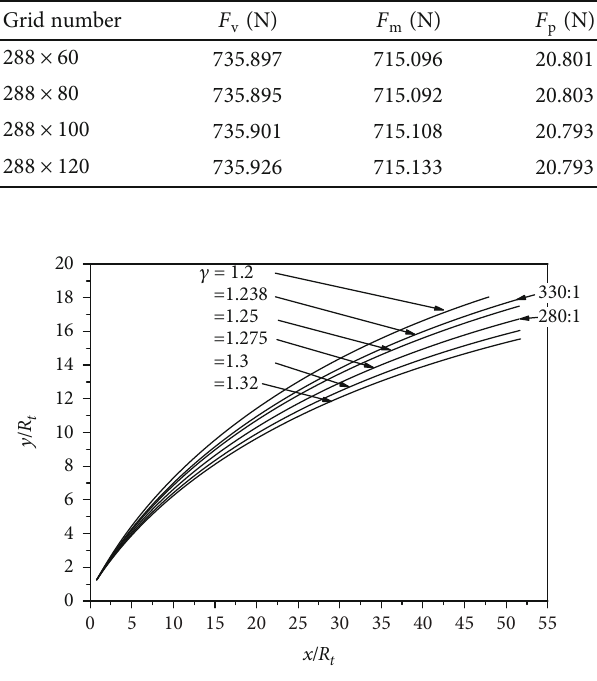
Figure 6: Expansion contours designed by various constant γ values.